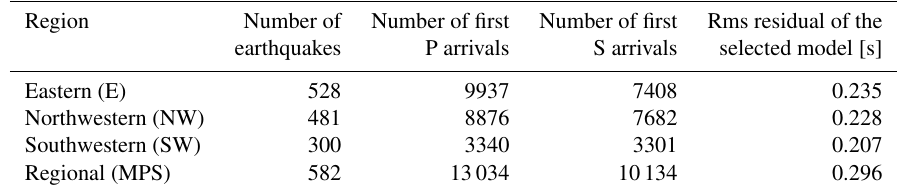
Table 3. Results of the selection procedure and the lowest rms residuals of the final P and S models obtained for each subregion. Region Number of Number of first Number of first Rms residual of the earthquakes P arrivals S arrivals selected model [s] Eastern (E) 528 9937 0.235 481 582 13034 10134